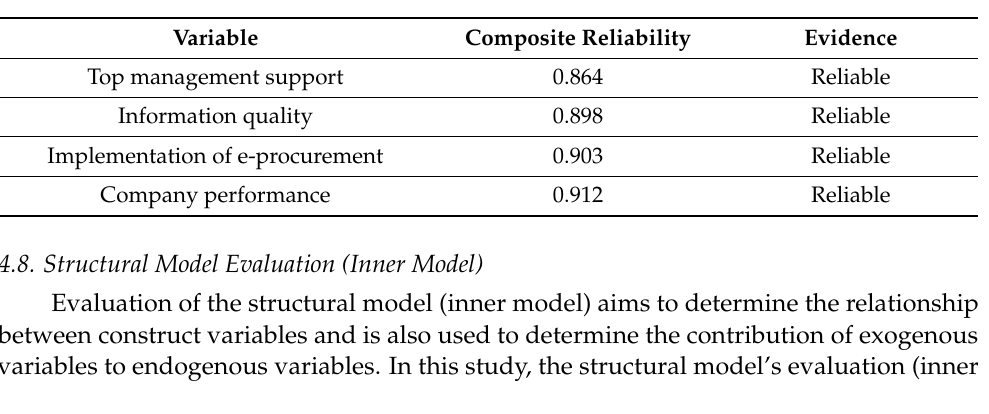
Table 7. Results of composite reliability